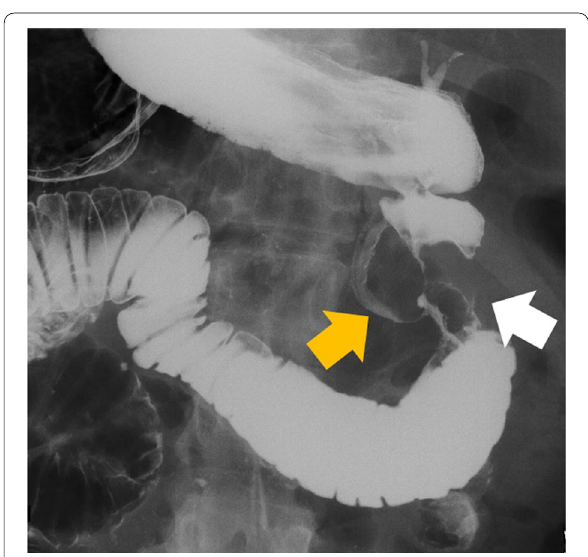
Fig. 2 Contrast duodenography image. Duodenal stenosis (white arrow) and bile duct reflux (orange arrow) with a hook-like